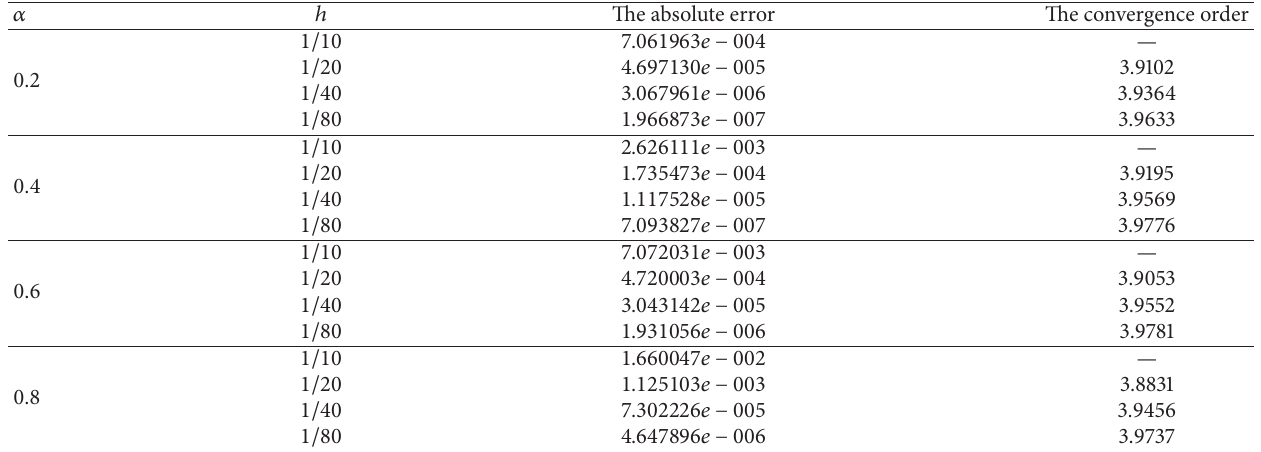
Table 6: The numerical results of the Example 9 by formula (14) with 𝑝 = 4